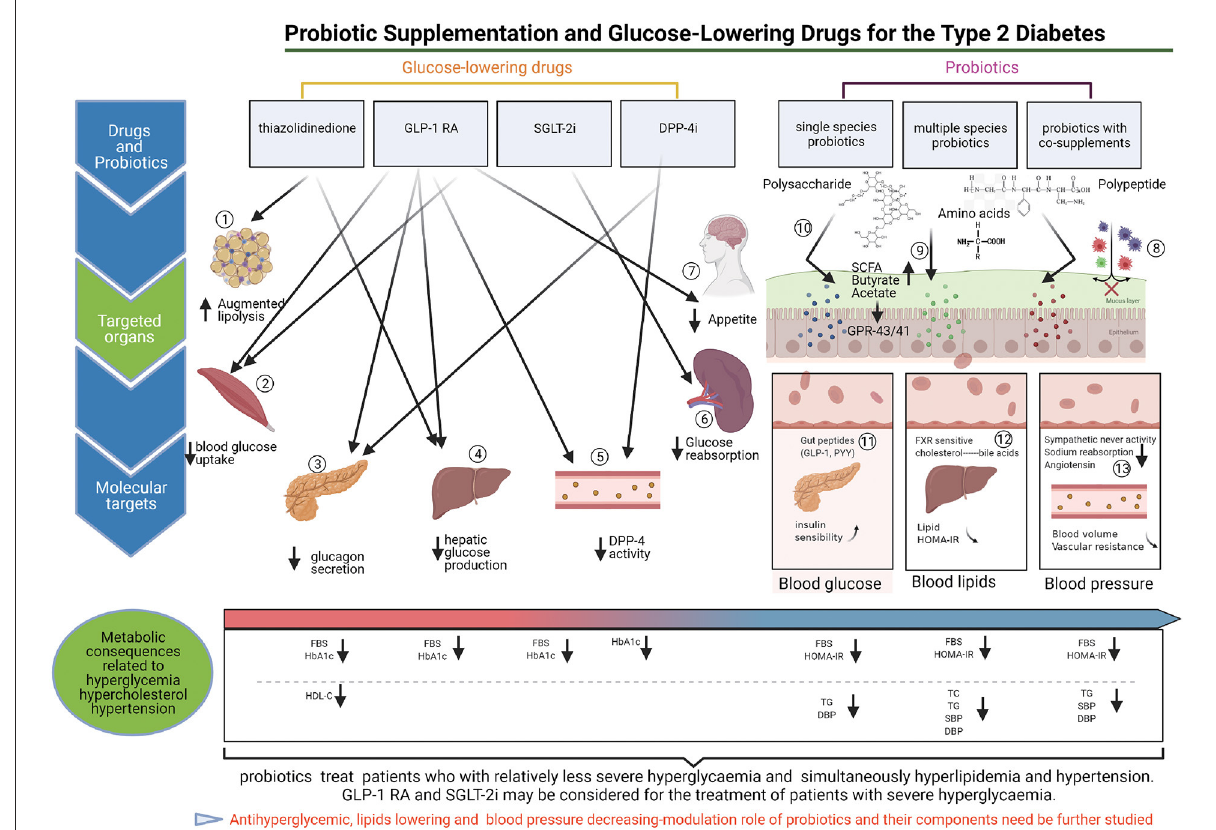
FIGURE6 The targeted regulation mechanisms of probiotics and glucose-lowering drugs on antidiabetic. (1) TZDs can inhibit lipolysis in adipose tissue, and decrease hyperglycemia. (2) TZDs and GLP1-RAs can promote blood glucose uptake by the skeletal muscle contributes to reduce blood glucose. (3) GLP1-RA can promote the secretion of insulin from pancreas, meanwhile, GLP1-RA and DPP-4i can inhibit glucagon secretion by pancreas, and contribute to reduce the blood glucose. (4) TZDs, and GLP1-RA can inhibit endogenous hepatic glucose production, and reduce hyperglycemia. (5) GLP-1RA can inhibit DPP-4 enzymatic activity in circulation participates in decrease blood hyperglycemia. (6) SGLT2i (Sodium-Glucose cotransporter 2 inhibitors) blocks glucose reabsorption in kidneys, and reduce the blood glucose. (7) GLP1-RA can inhibit appetite by the brain, contribute to decrease blood glucose